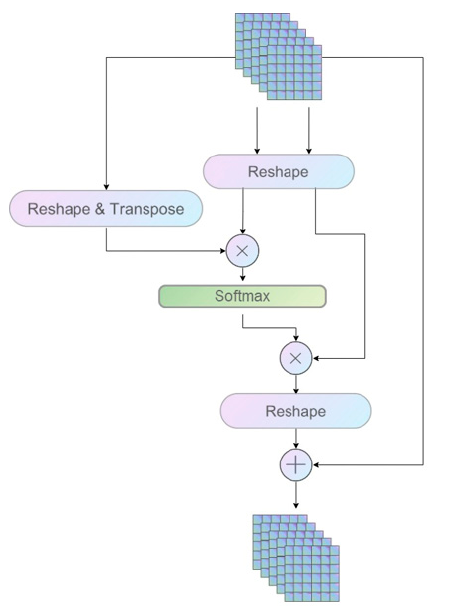
Figure 2. The framework of the four-level PFA hierarchy. For downsampling operations, AD blocks are used. We set the downsampling rate to 2, which means that, after a downsampling operation, the feature map will be reduced to half the original size. In contrast, the number of channels will double. The first-level feature map is directly input into the backbone of MAFF-HRNet without downsampling, and the other three layers are fused with the matching feature map in the network structure through downsampling.